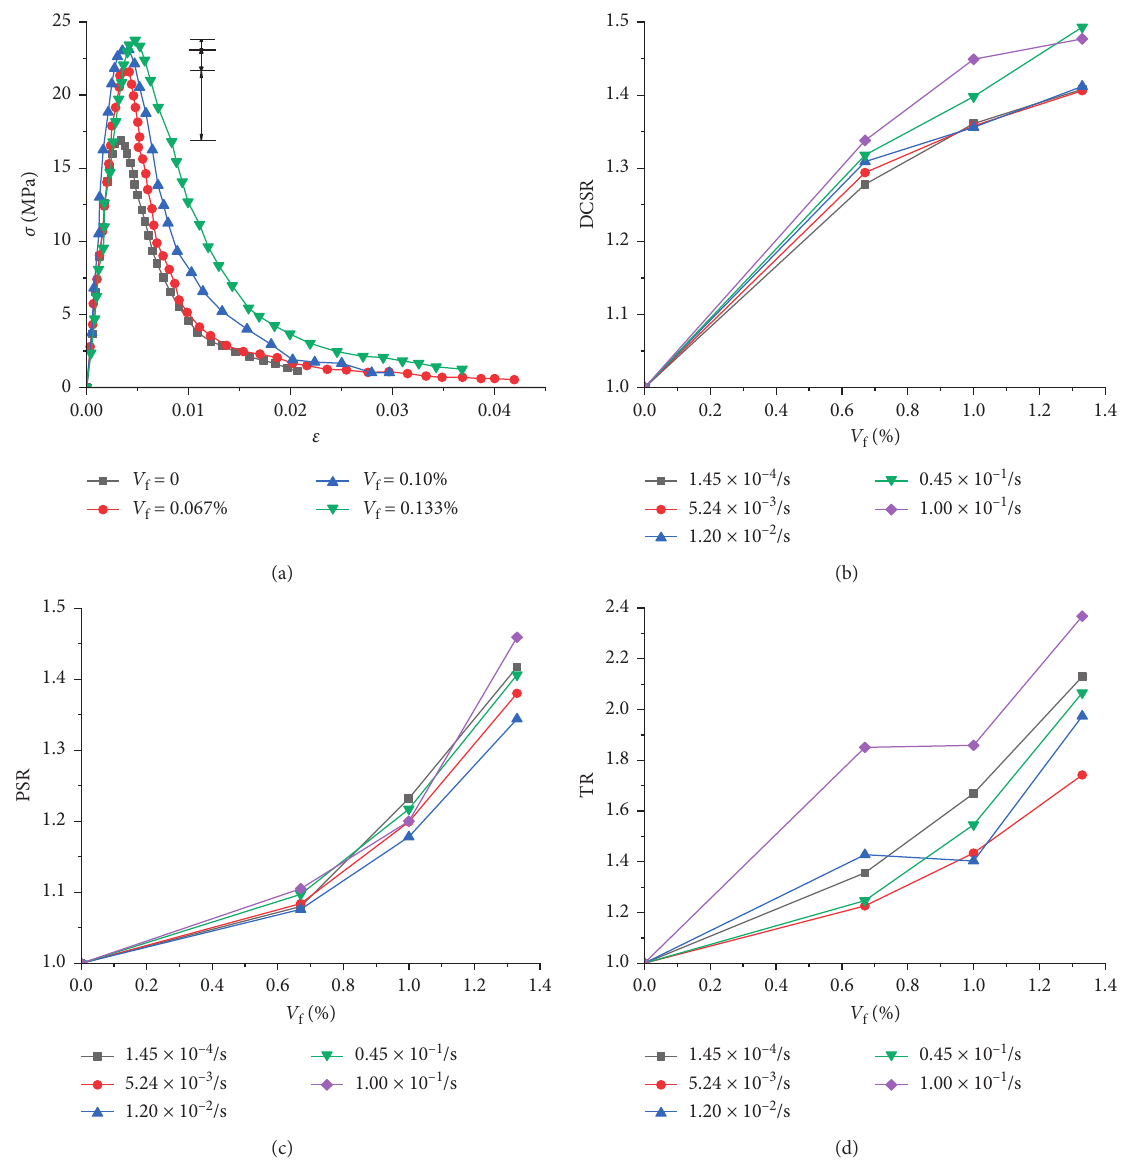
Figure 6: (a) Dynamic compressive stress-strain curves of PFRC at _ ε � 1 . 45 × 10 − 4 /s. (b) Relationship between polypropylene fiber content ( V f ) and DCSR of PFRC. (c) Relationship between polypropylene fiber content ( V f ) and PSR of PFRC. (d) Relationship between polypropylene fiber content ( V f ) and TR of